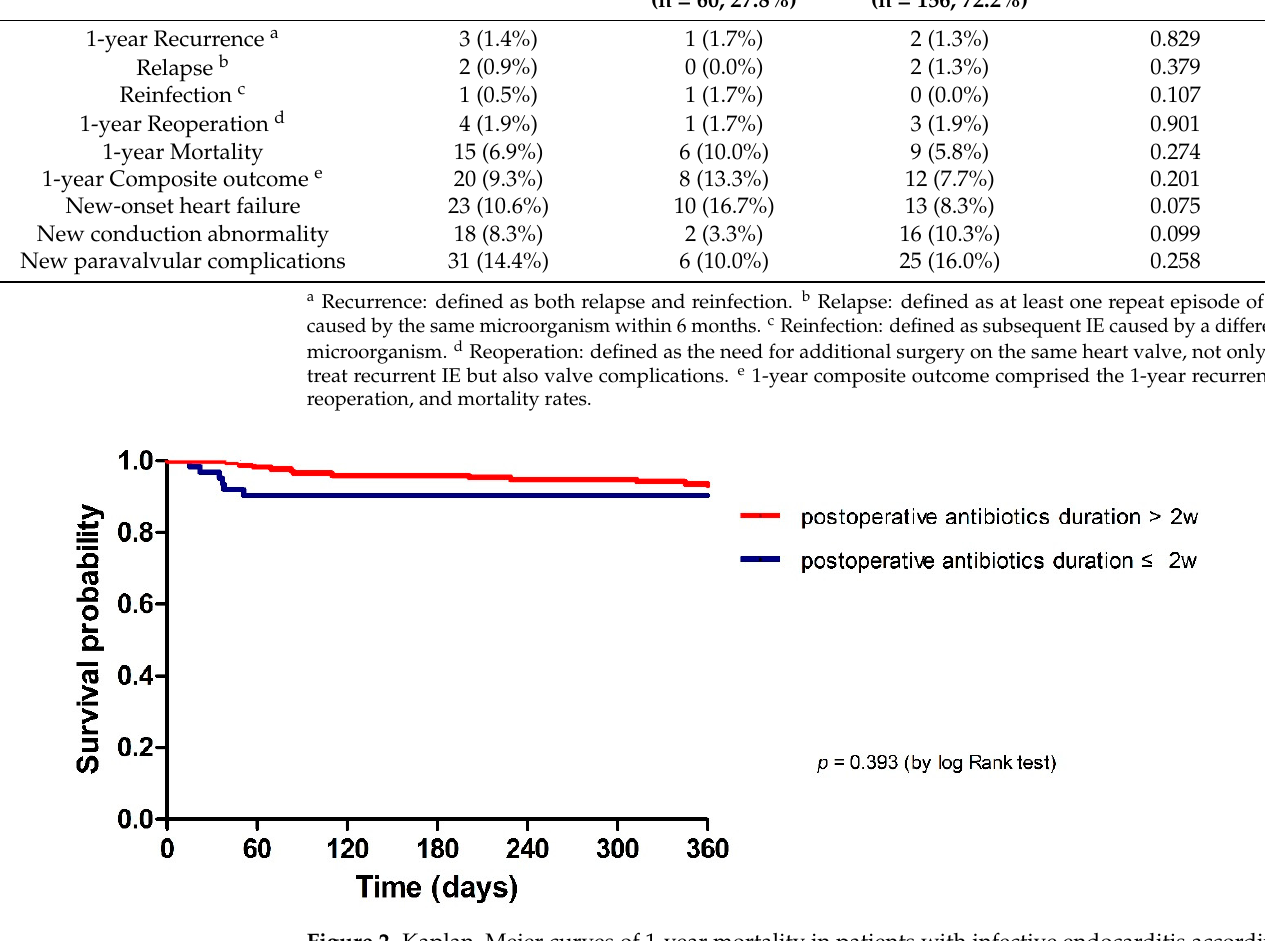
Figure 2. Kaplan–Meier curves of 1-year mortality in patients with infective endocarditis according to the duration of postoperative antibiotic usage.